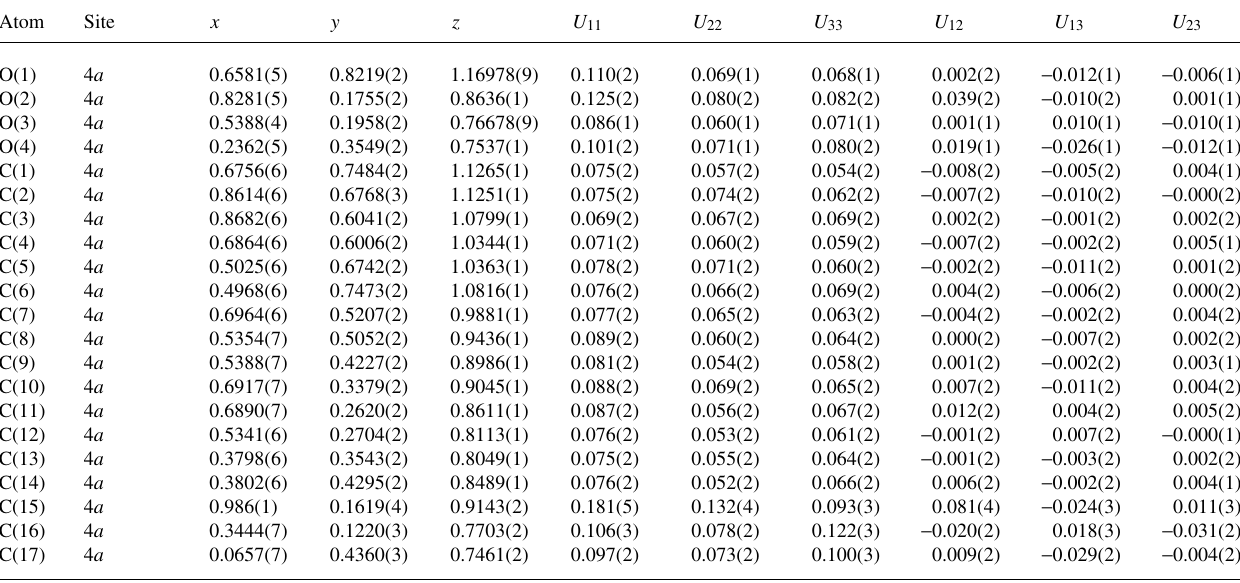
Table 3. Atomic coordinates and displacement parameters (in Å 2 ) .